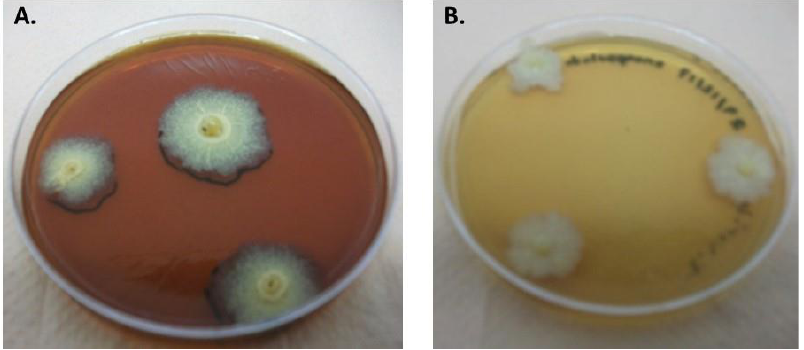
Figure 12. Streptomyces CDBB1232 spore cultures after being subjected to the processes of ( A ) im- mobilization in calcium alginate and dehydration with an airflow of 4 L min −1 , ( B ) immobilized biomass dehydrated at 30 °C for 6 days.